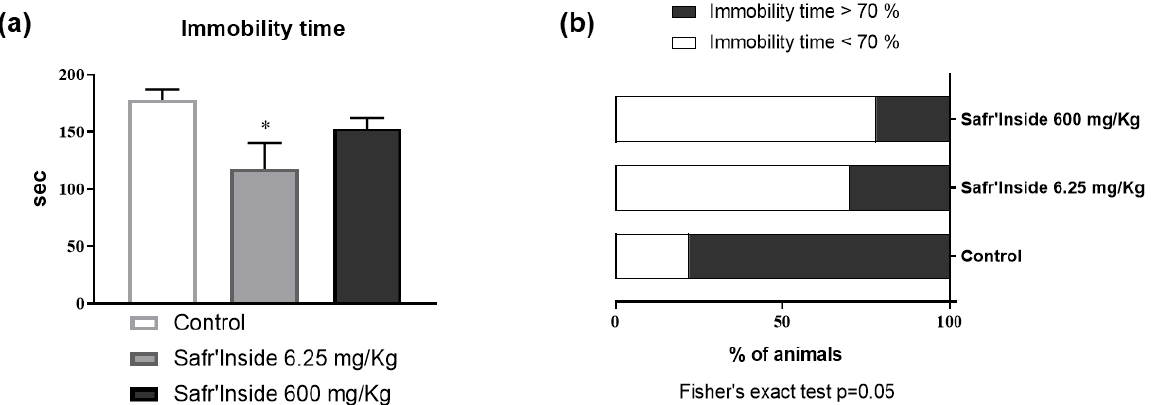
Figure 2. Effect of acute oral administration of Safr’Inside TM (6.25 and 600 mg/Kg) on depressive-like behavior measured in the FST. ( a ) Immobility time; ( b ) Index of immobility. FST has been conducted 30 min after gavage. Results are shown as mean ± SEM. Control (Water): n = 9; Safr’Inside (6.25 mg/Kg): n = 10; Safr’Inside (600 mg/Kg): n = 9. * p < 0.05.